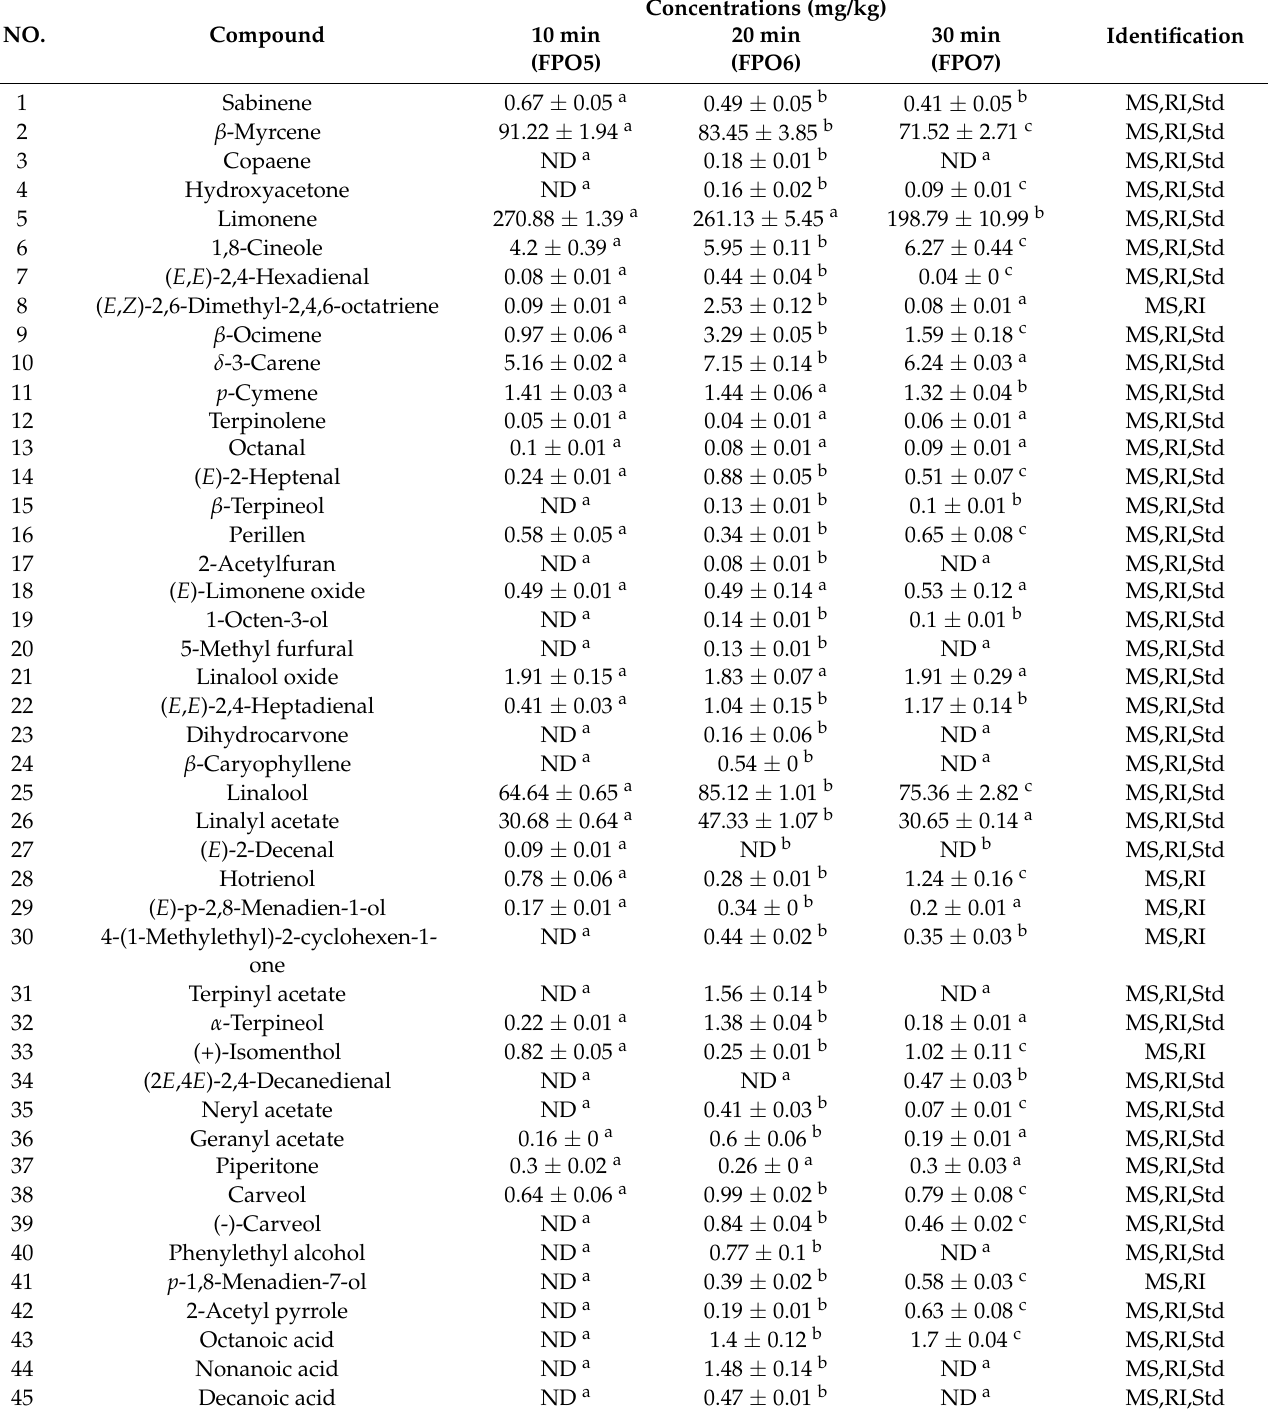
Table 2. Volatile compounds in pepper oils with different frying times as determined by